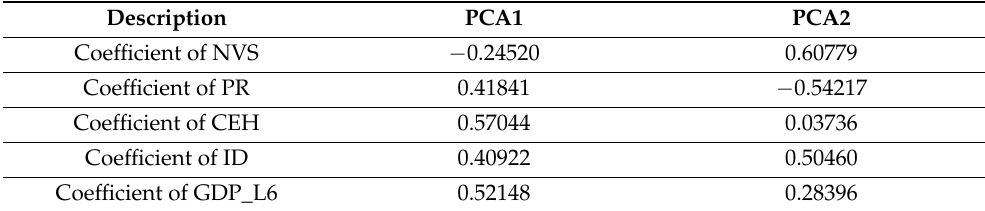
Table 5. Model 32680 PCR coefficients.